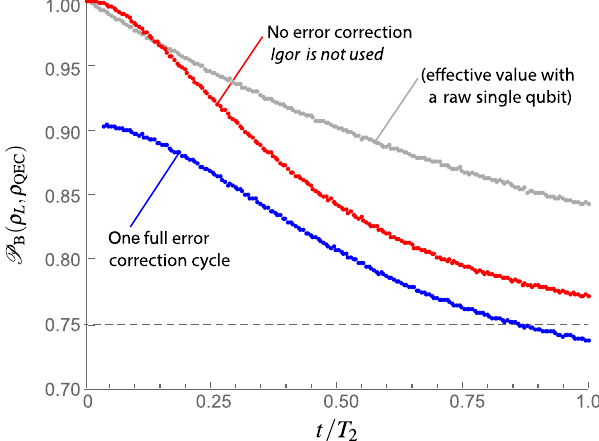
FIG. 23. Success probability P species protocol QEC cycle with multiqubit MS gates (cf. Fig.